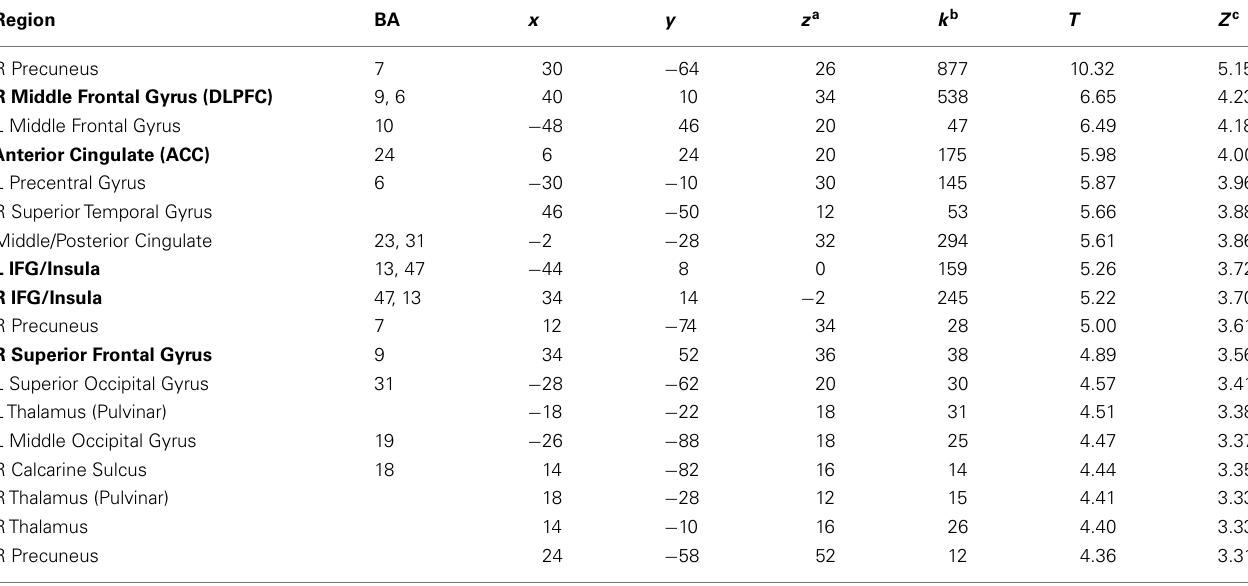
Table 2 | Response to incongruent trials relative to congruent trials in the absence of emotionally salient